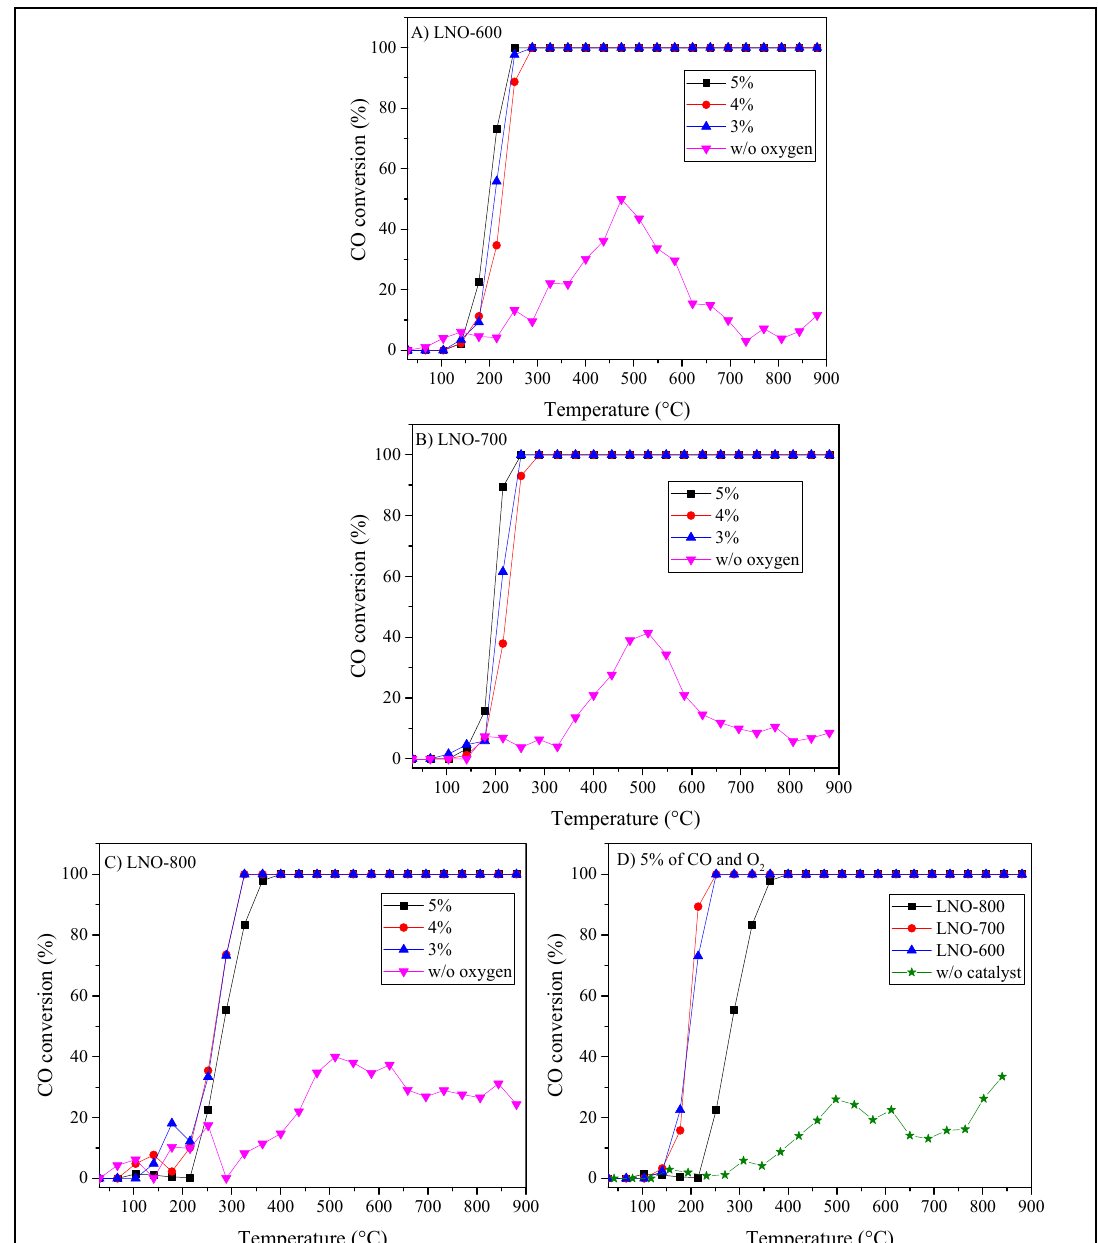
Figure 10. Dynamic CO conversion for LaNiO 3 samples calcined at 600 ( A ), 700 ( B ), and 800 °C ( C ), using different CO and O 2 concentrations. Additionally, a direct comparison of the dynamic analysis of the three LaNiO 3 samples is included, using 5% of CO and O 2 ( D ).